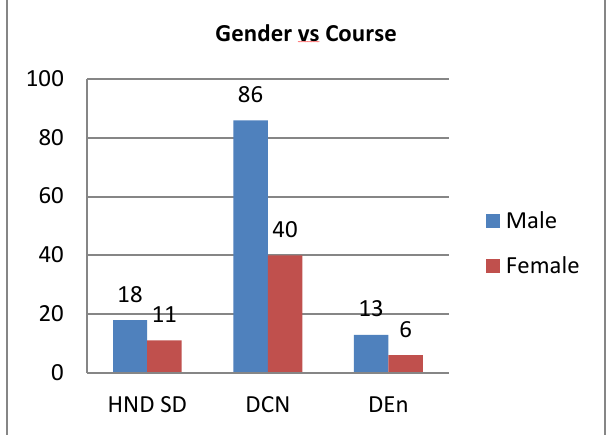
Figure 1. Gender versus Course